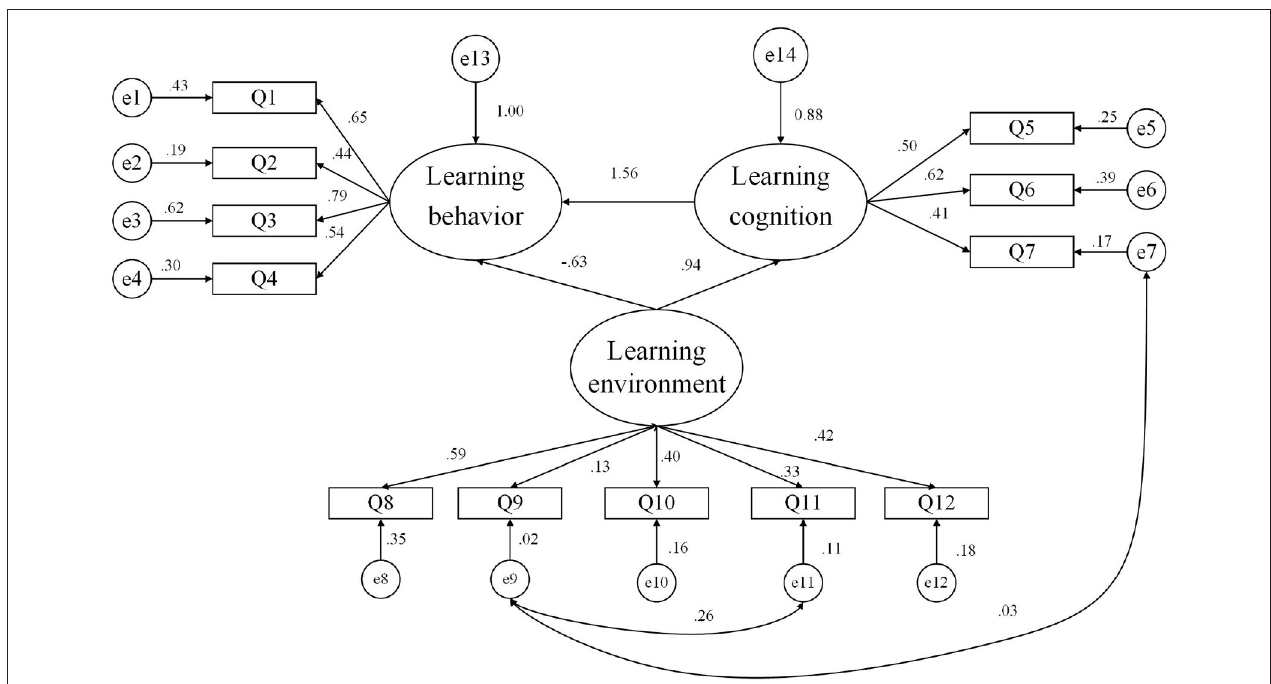
FIGURE 3 | The revised structural equation model.